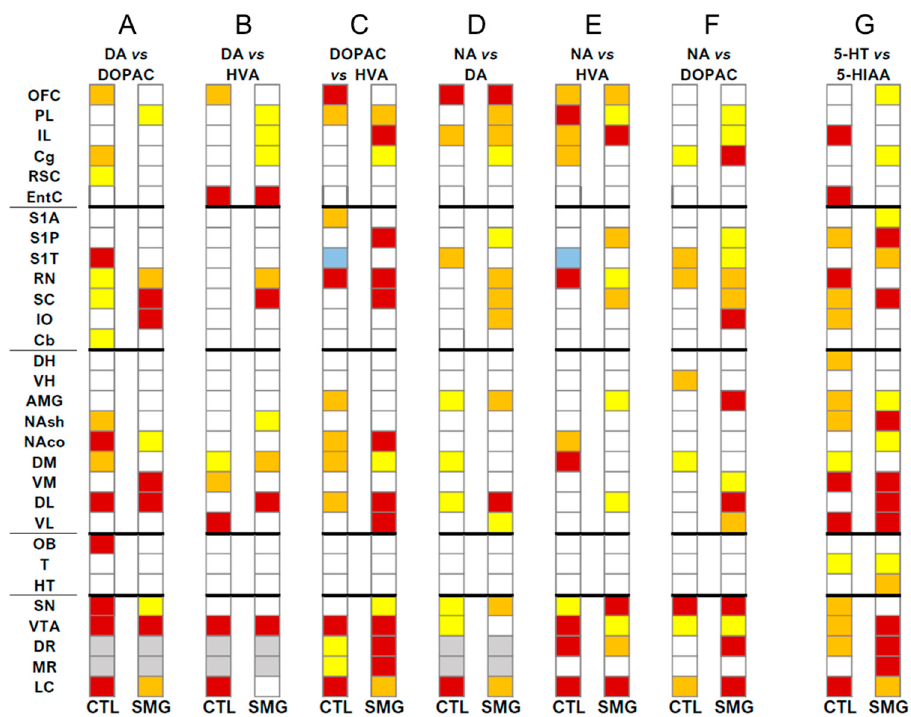
Figure 8. Correlations established between compounds by brain regions for CTL and SMG rats. ( A ). DA vs. DOPAC. ( B ). DA vs. HVA. ( C ). DOPAC vs. HVA. ( D ). NA vs. DA. E. NA vs. HVA. F. NA vs. DOPAC. G. 5-HT vs. 5-HIAA. Positive correlations are reported in yellow (r > 0.6) to red (r > 0.8). Negative correlations are reported in light blue (r < − 0.6). Only significant correlations ( p < 0.05) are reported.